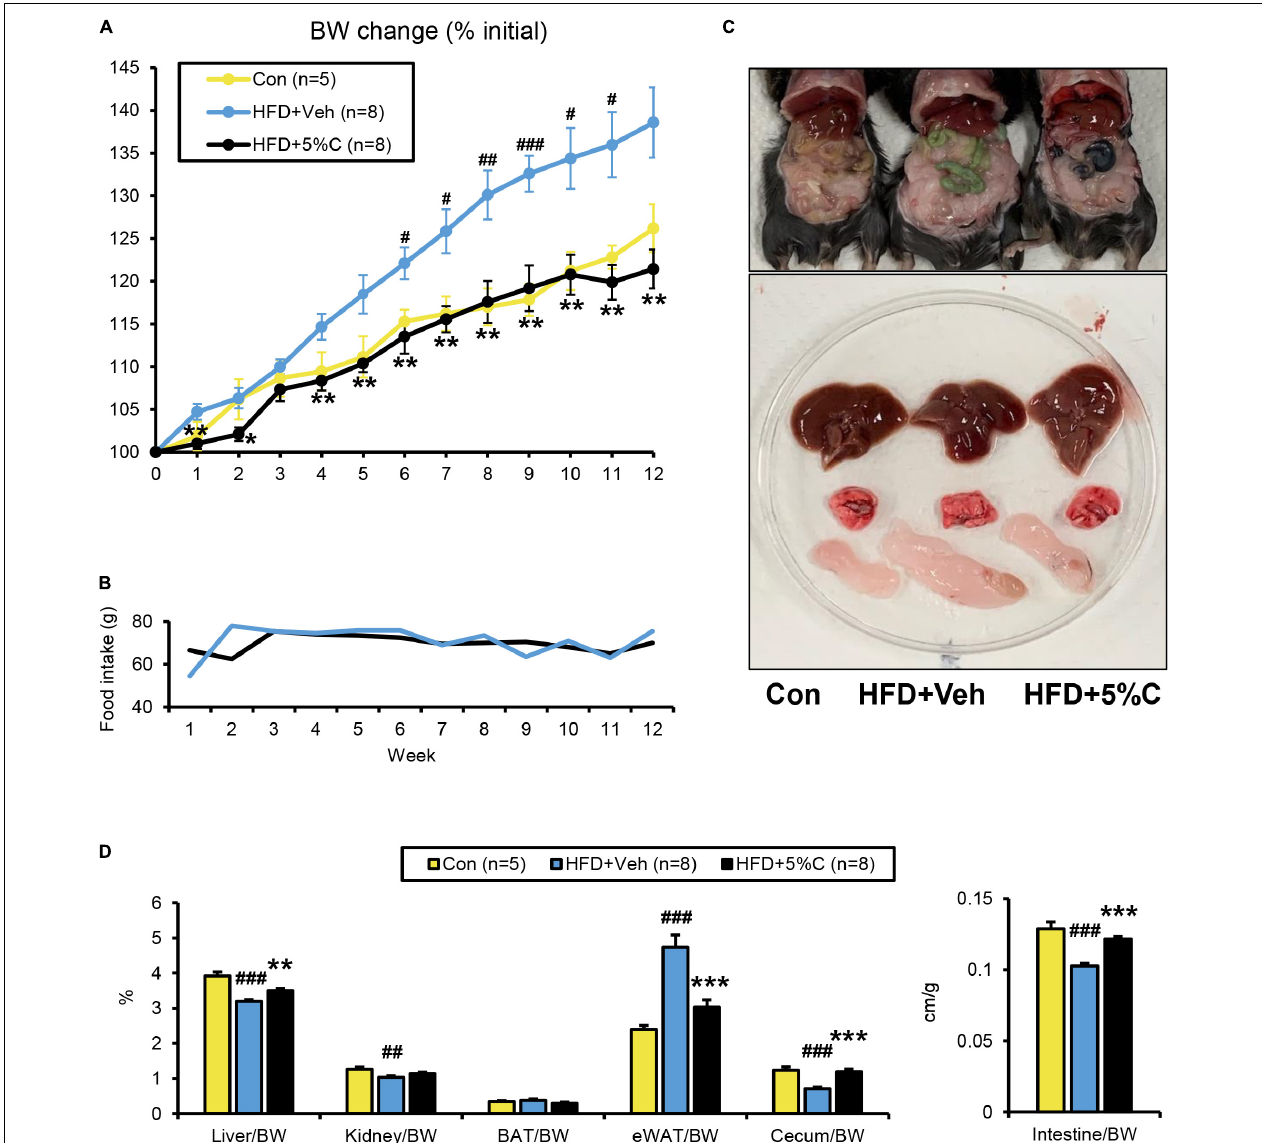
FIGURE 1 | A diet containing acidic activated charcoal can improve obesity in mice fed HFD after 12 weeks of treatment. (A) Changes in BW. (B) Food intake. (C) Gross appearance of representative mice from the three groups. From top to bottom, the liver, lung and epididymal white adipose tissue (eWAT) are shown. (D)